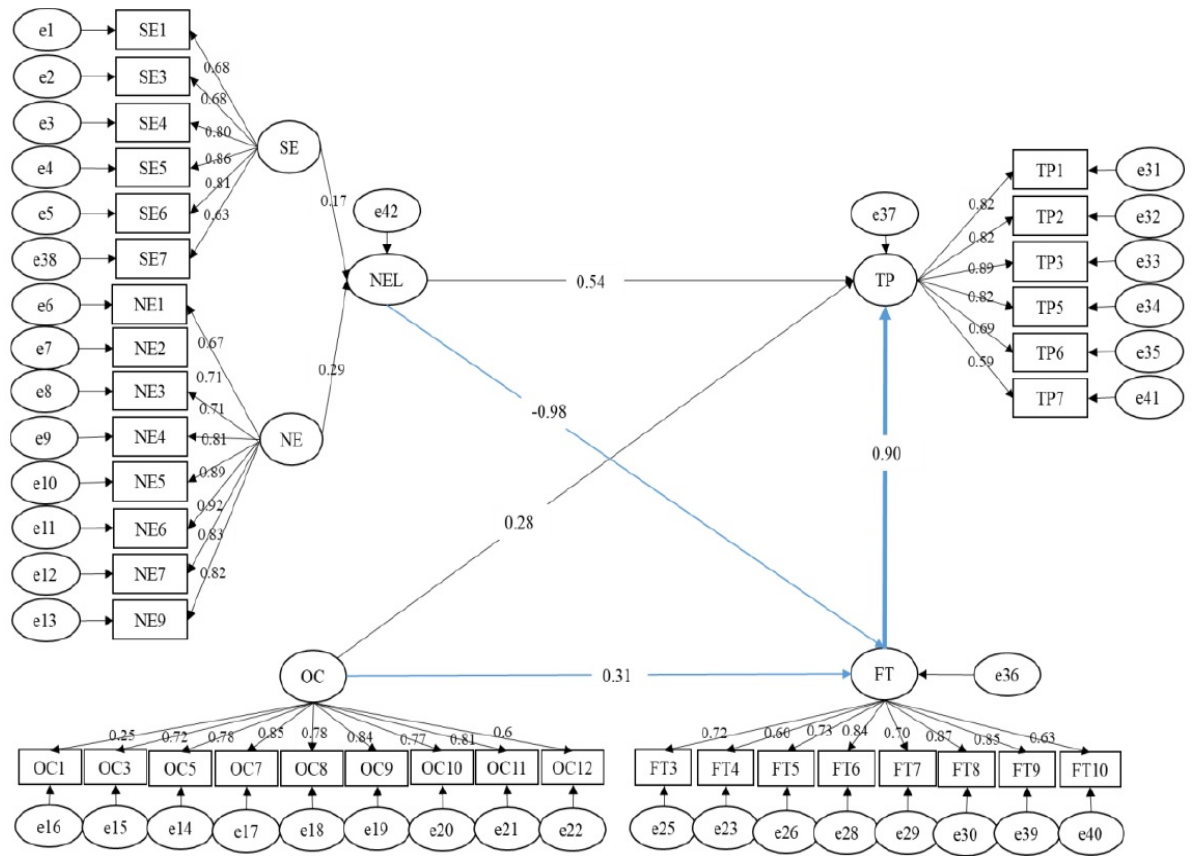
Figure 2. Mediation Model of Fatigue on Nature Elements and Organisational Culture’s Relation